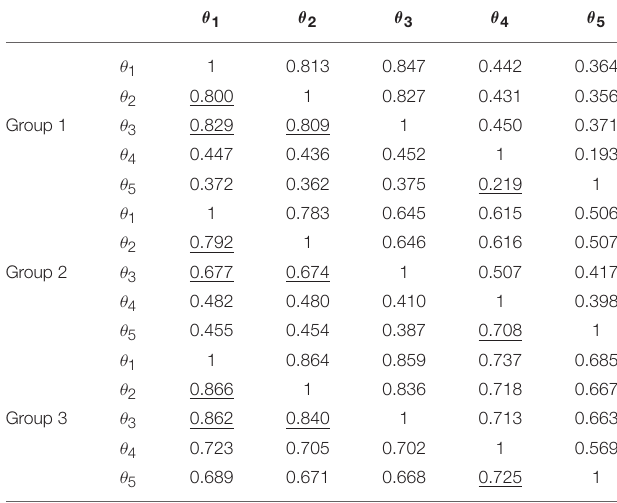
TABLE 5 | Derived correlation matrices from the bivariate HO-IRT model (lower off-diagonal) and from the univariate HO-IRT model (upper